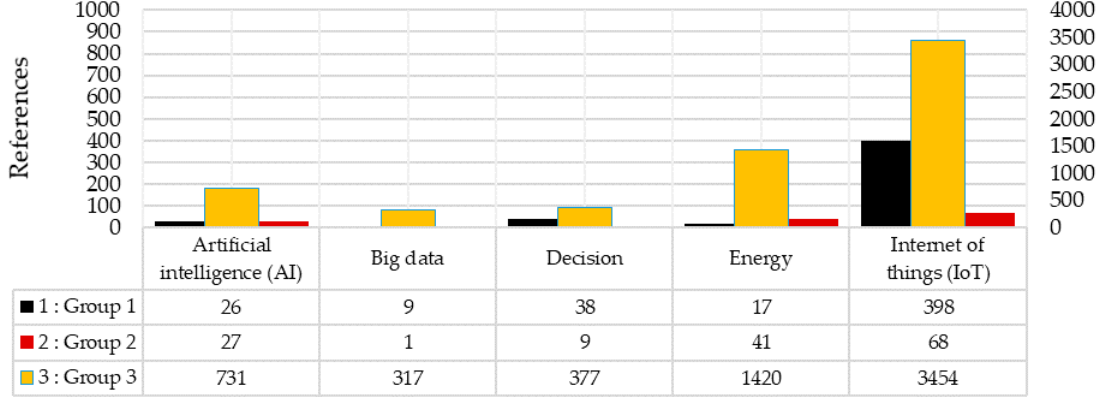
Figure 6. A number of references for each keyword within each group. Note: the left vertical axis shows the number of references for Groups 1 and 2, and the secondary vertical axis on the right shows the numbers for Group 3.